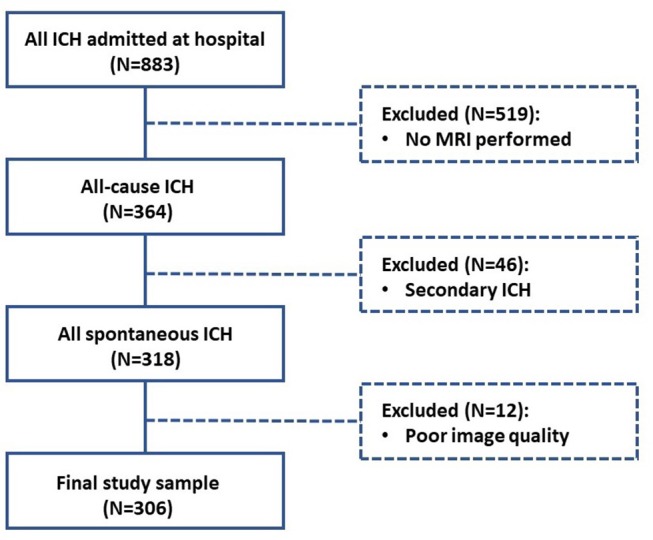
Flow diagram of study enrollment.